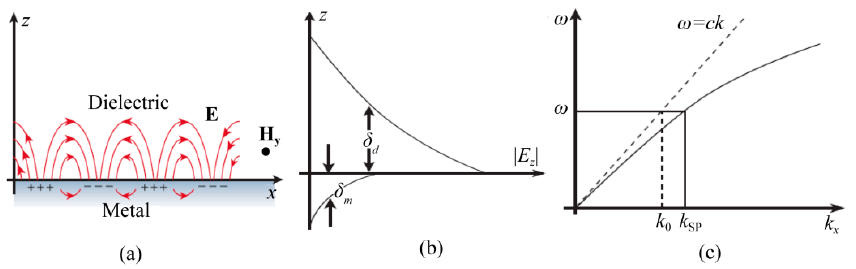
Figure 1. ( a ) SPPs (surface plasmon polaritons) on a dielectric–metal interface ( H is in the y direction); ( b ) Field distribution of SPPs in the dielectric and metal material, δ d and δ m is the decay length of the field in the dielectric and metal material, respectively; ( c ) Dispersion curve for an SPP mode. Reproduced from [29]. Copyright © 2003, NPG.